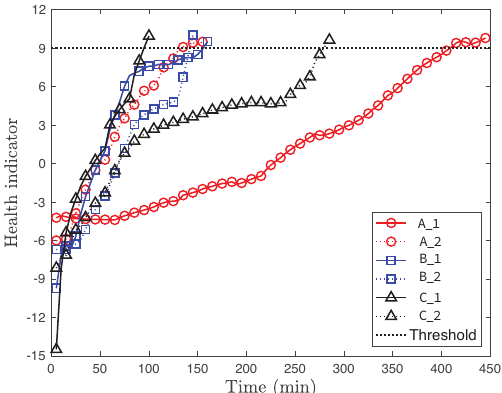
Figure 5. Health indicator of training cases Bearing A _ 1 , Bearing A _ 2 , Bearing B _ 1 , Bearing B _ 2 , Bearing C _ 1 , Bearing C _ 2 as a function of experimental time.